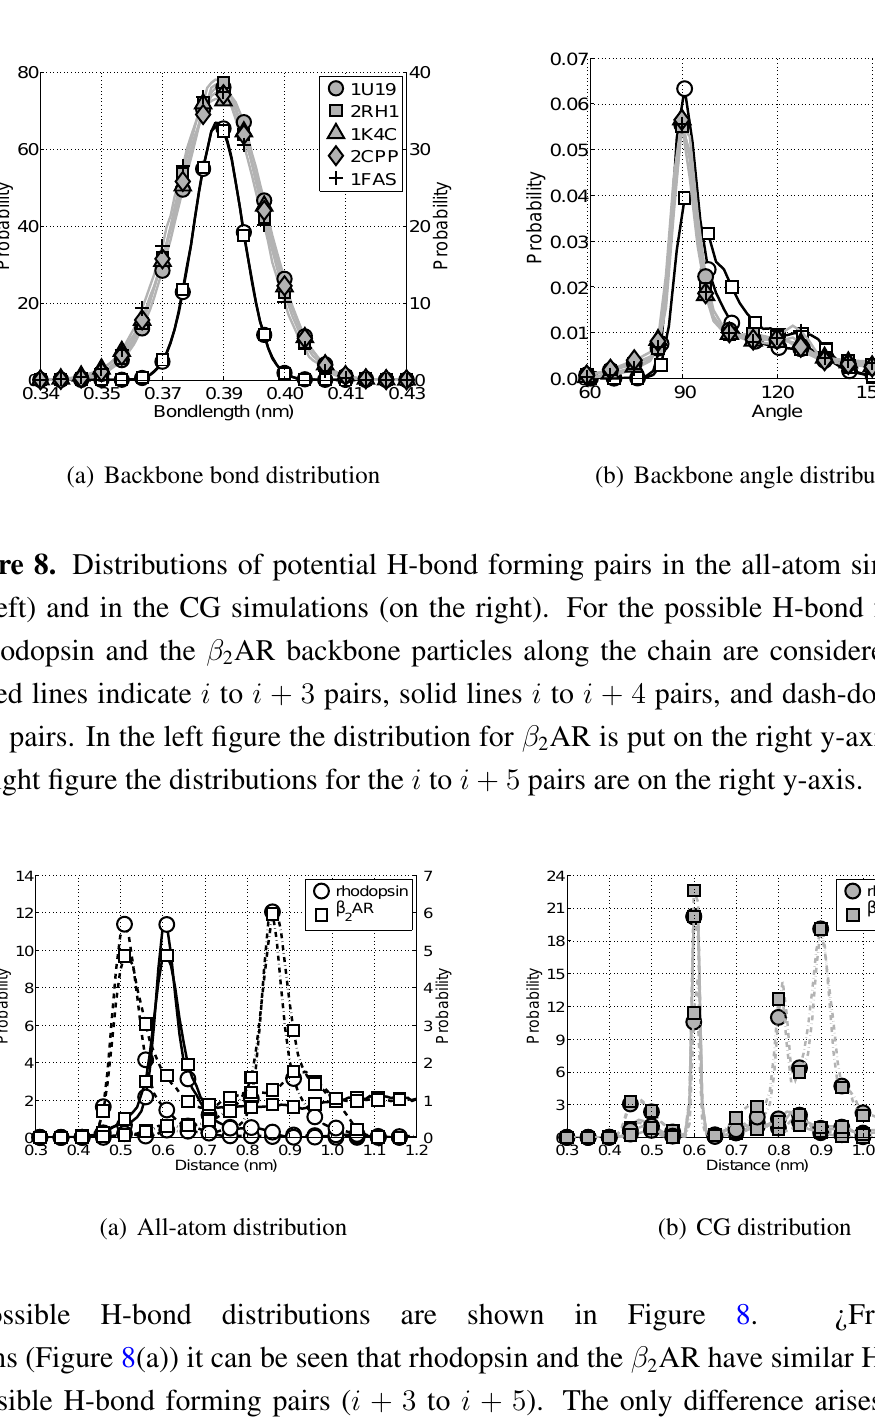
Figure 7. In (a) the backbone bond distributions for both all-atom simulations (black lines) and the five CG simulations (gray lines) are shown. Using a similar color scheme the backbone angle distributions are shown in (b). The all-atom simulations are on the left axis, and, if applicable, the CG simulations on the right axis. The protein data bank codes for the proteins are used in the legend, see Table 1.